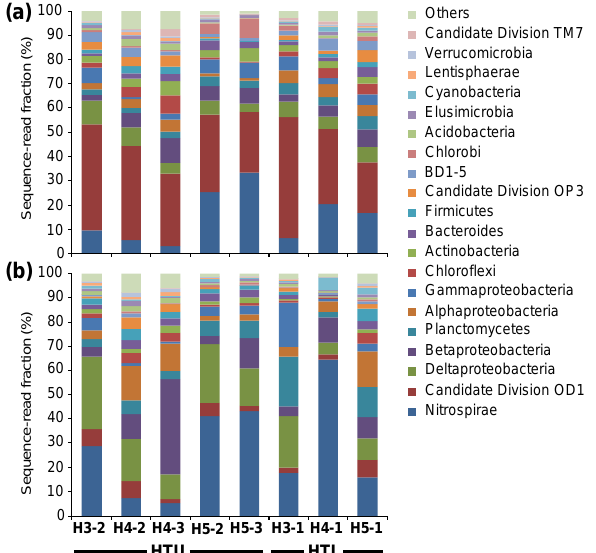
Figure 8. Taxonomic classification (phylum level) of the bacterial communities in the groundwater of the eight different wells from the upper aquifer assemblages (HTU) or the lower aquifer (HTL). (a) Bacterial communities based on sequencing of 16S rRNA genes from extracted genomic DNA. (b) Bacterial communities based on sequencing of RNA-derived 16S rRNA amplicons.